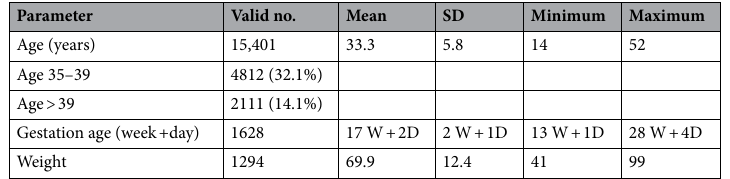
Table 2. Demographic and clinical data of patients (valid number column indicate the available data for each parameter).